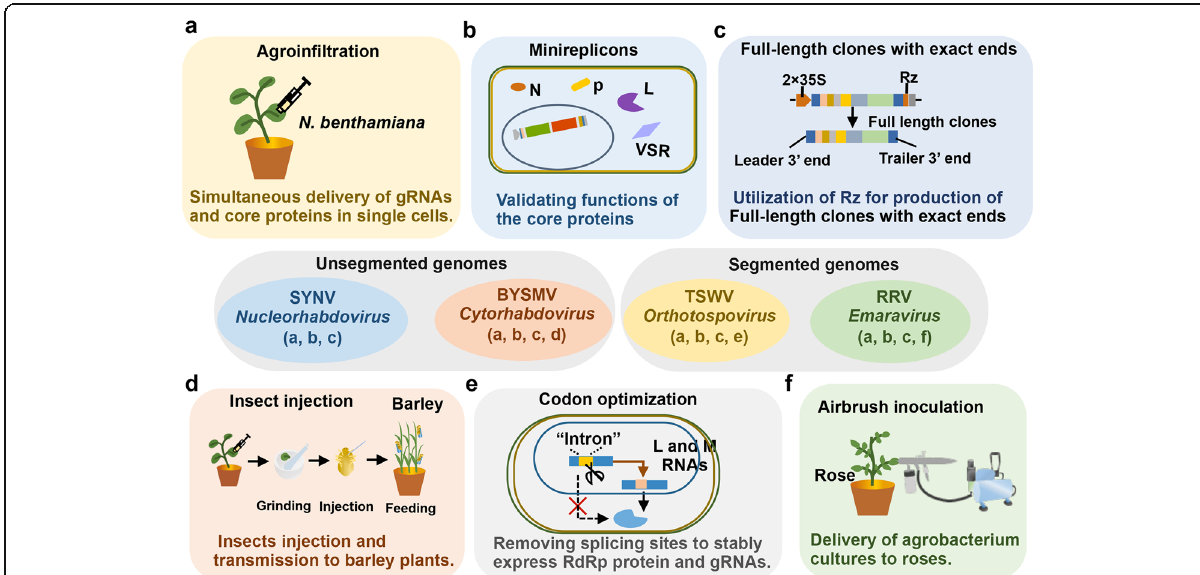
Fig. 1 Combined strategies used in development of reverse genetics systems of plant NSR viruses. a Agrobacterium tumefaciens -mediated expression of genes in N. benthamiana leaves was utilized for simultaneous delivery of plant NSR viruses core protein genes and genomic RNAs in single cells. b The minireplicon (MR) containing a double cauliflower mosaic virus 35S (2 × 35S) promoter, exact termini of the virus, gene junctions, and reporter genes could replicate in conjunction with the ectopic expression of viral core proteins and VSRs, which could validate whether the core replicate proteins are functional in viral transcription and replication. c Full-length viral antigenomic RNA (agRNA) was cloned into the A. tumefaciens binary vector containing a 2 × 35S promoter and a ribozyme (Rz) for cleavage of the 5 ′ and 3 ′ ends of the transcribed agRNAs with exact termini. d Insect-mediated transmission of rBYSMV from N. benthamiana leaves to monocot plants. Grinding the infected N. benthamiana leaves and injecting the extracts into the thoraxes of SBPHs. The rBYSMV could be recovered in the SBPHs. After a period of incubation, the infected SBPHs transmitted recombinant viruses to barley plants. e Codon optimization removed cryptic splicing sites in the cDNA of TSWV L and M RNAs for stable expression of the large RdRp protein and genome RNAs in plants. f Inoculation by an airbrush was effective in delivering agrobacterium cultures containing RRV vectors to A. thaliana , N. benthamiana and roses. In the middle panels, combined technologies were used for developing the reverse genetics systems of SYNV, BYSMV, TSWV, and